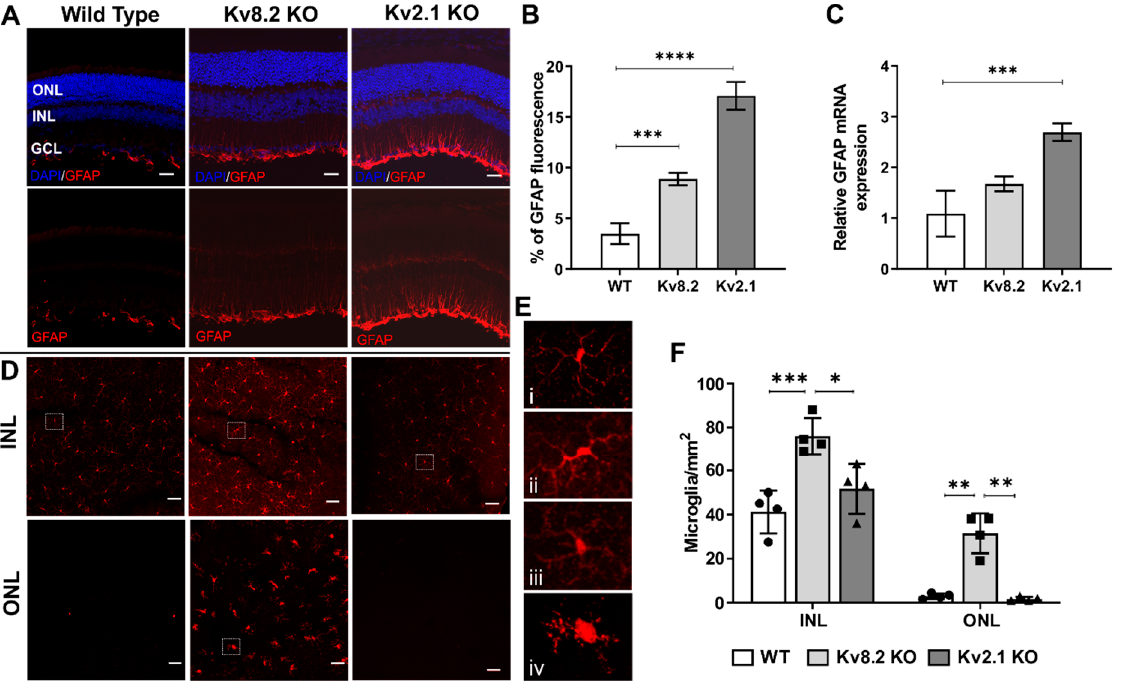
Figure 4. Glia activation in Kv deficient retinas. ( A ) Glial fibrillary acidic protein (GFAP) retinal expression in wild type, Kv8.2 KO and Kv2.1 KO animals. Upper panels show nuclear stain (DAPI, blue) and GFAP (red) co-localisation. Boomt panels show GFAP (red) expression only. Scale bar = 50 μ M ( B ) Fluorescent quantification of GFAP protein expression in the three mouse lines showing significantly higher expression in both Kv KO lines compared to WT. ( C ) Quantification of Gfap gene expression via qPCR showing a significant increase in expression in Kv2.1 KO retinas compared to wild type ( n = 3 for each genotype). ( D ) Confocal images of retinal flatmounts labeled with microglia marker Iba-1 (red) taken at the inner nuclear layer (INL) and outer nuclear layer (ONL) regions to show proliferation and migration of activated microglia in the Kv8.2 KO retina. Scale bar = 50 μ M. ( E ) Higher magnification images of individual microglia cells from WT (i), Kv8.2 KO INL (ii) and ONL (iii), and Kv2.1 KO INL (iv) showing the morphological differences in cell body shape. ( F ) Quantification of microglia numbers in the INL and ONL in the wild type, Kv8.2 KO and Kv2.1 KO retinas. Results are presented as mean +/ − SD from n = 3, and p values were obtained through two-way ANOVA and Tukey’s multiple comparison test post hoc with * p < 0.02, ** p < 0.004, *** p < 0.0006, **** p < 0.0001.